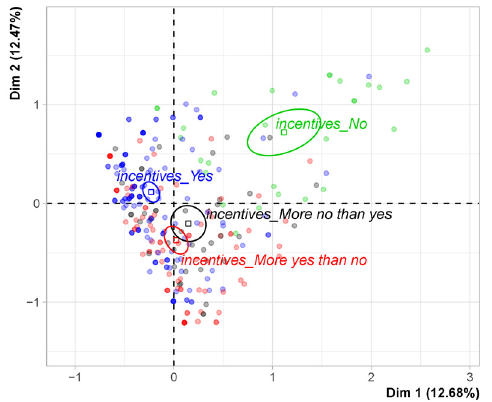
Figure A9. MCA. Distribution of respondents by attitudes towards reduced working hours.